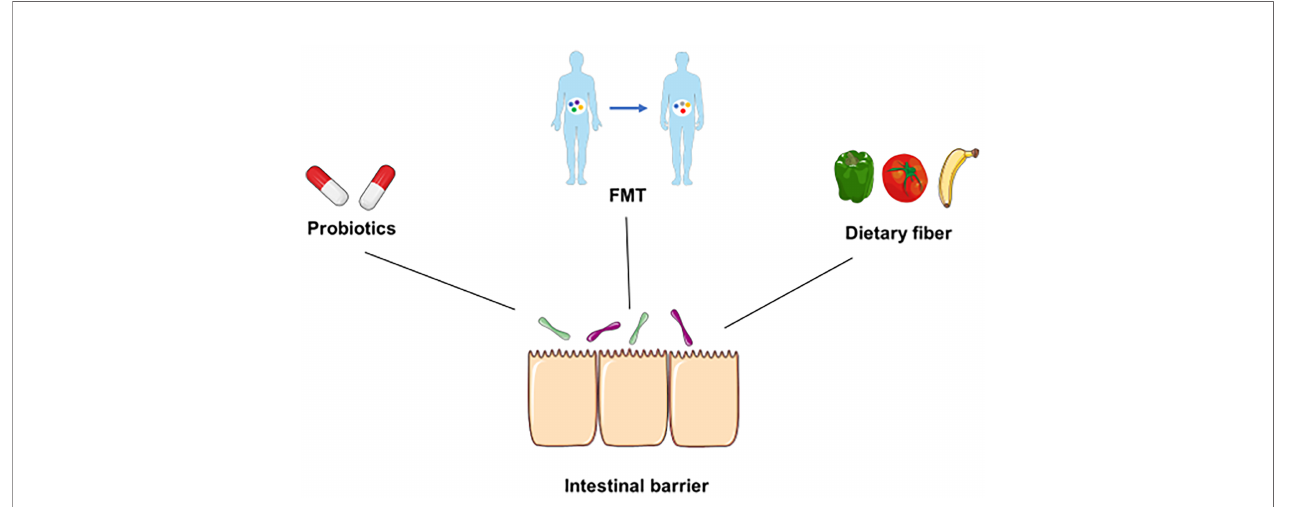
FIGURE 3 | Underlying prevention and therapeutic strategies for infection. Some underlying prevention or therapeutic strategies, such as probiotics, FMT, and dietary fi ber, can directly suppress pathogens, modulate the diversity of the gut microbiota, and maintain the integrity of the intestinal barrier during